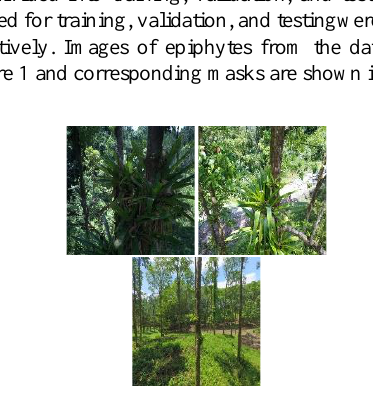
Figure 1: Example images from the dataset in which Werauhia Kupperiana is present with a) poor illumination b) good illumination and occupancy c) low occupancy